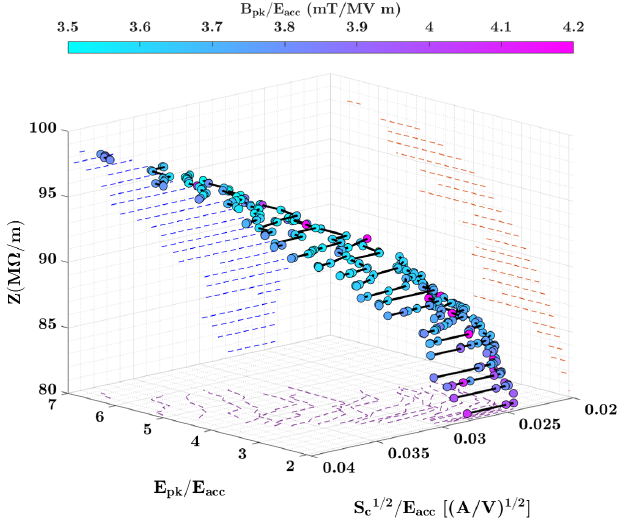
p ffiffiffiffiffi =E =E S vs 3D scatter plot of Pareto c pk acc acc